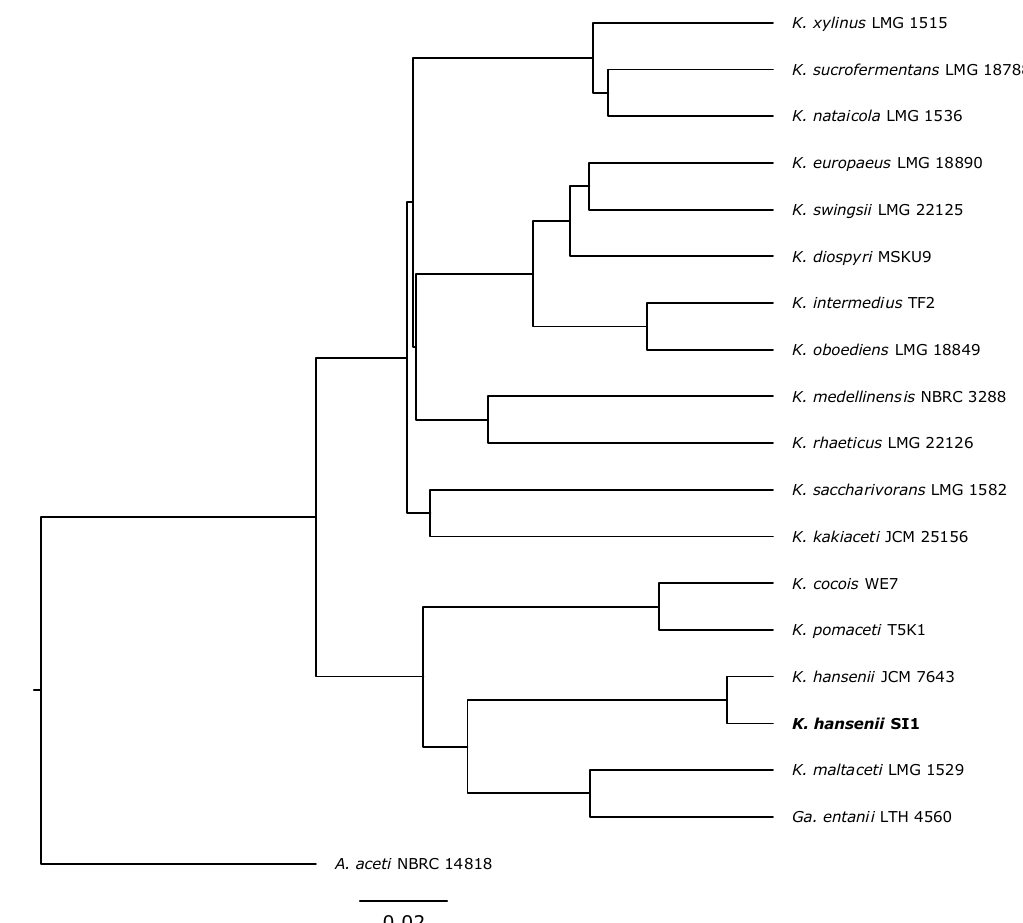
Figure 1. Phylogenetic relationship of the newly isolated Kombucha strain and type Komagataeibacter strains. The phylogenetic tree was constructed on ANI-1 values calculated based on whole-genome alignment. The A. aceti NBRC 14,818 was used as an outgroup. The tree was drawn in the FigTree program (v. 1.4.4). The scale bar represents the sequence divergence.